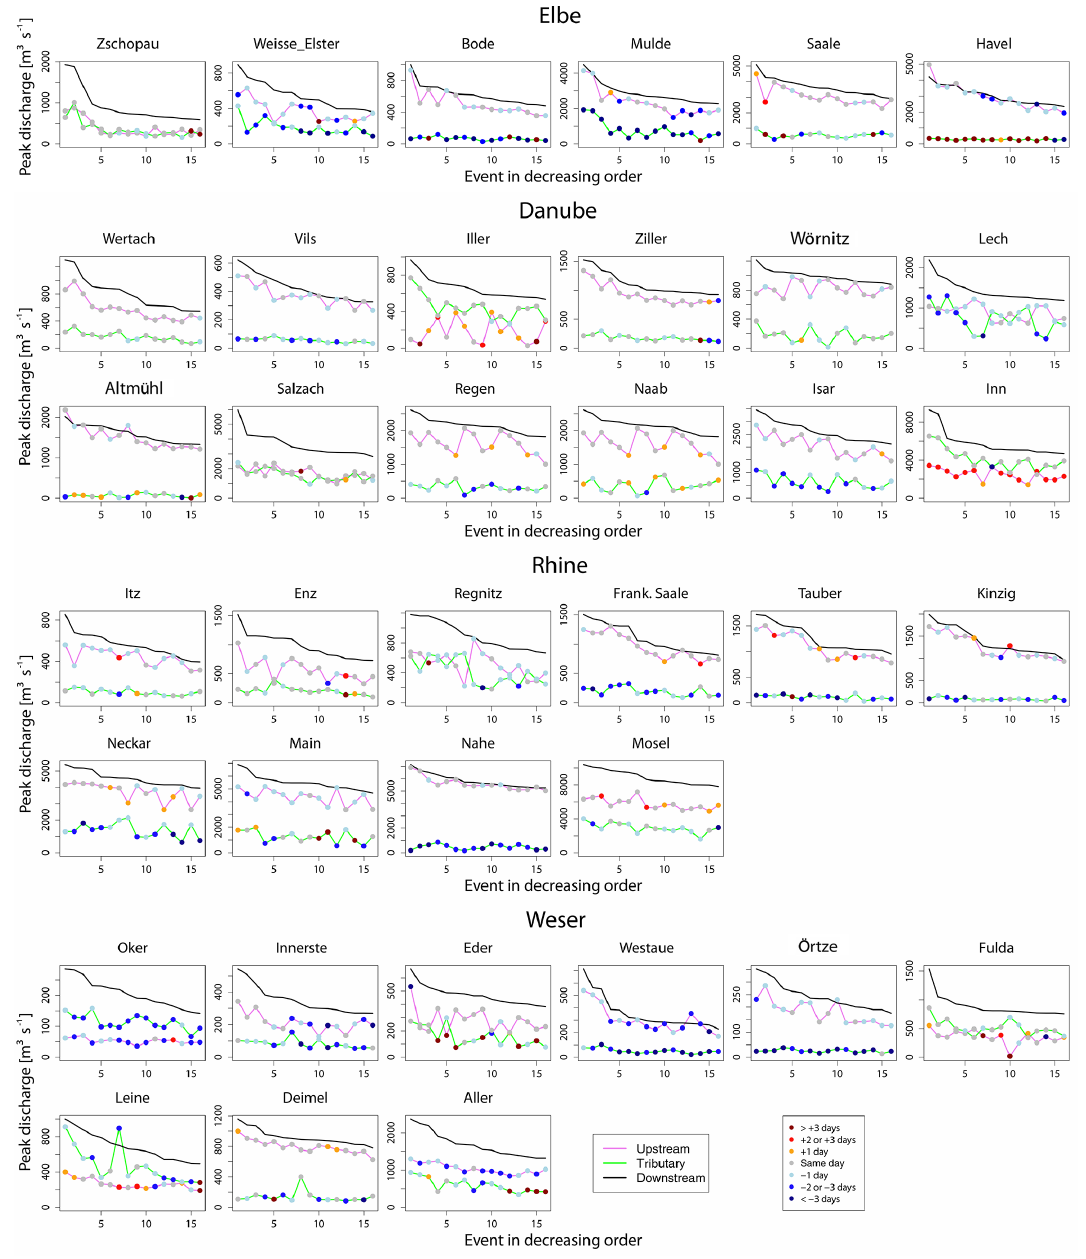
Figure 7. Event peaks at the upstream, tributary and downstream gauges, shown in decreasing order according to the downstream peak discharge. The points show the timing of the upstream and tributary peak in relation to the downstream